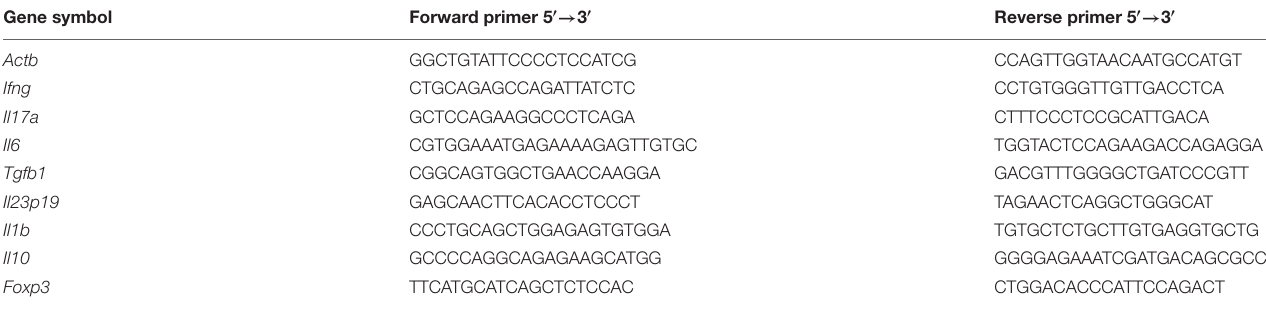
TABLE 1 | Primers used in the gene expression analysis. Gene symbol Forward primer 5 (cid:48) → 3 (cid:48) Reverse primer 5 (cid:48) → 3 (cid:48)